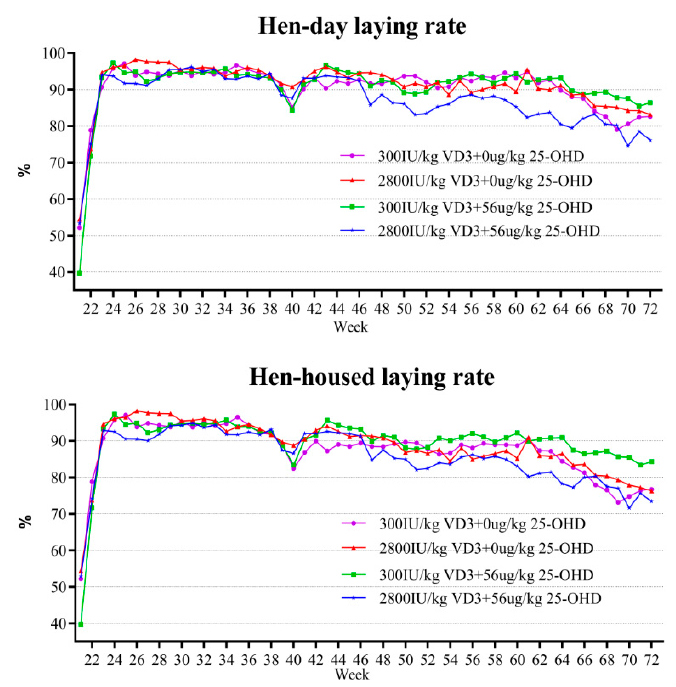
Figure 1. Effects of VD 3 level and 25-OHD in the diet of 1–20-week-old laying hens on laying rate from 21 to 72 weeks. 25-OHD, 25-hydroxyvitamin D 3 . The number of hen-housed was calculated according to the actual number of birds at the age of 21 weeks.